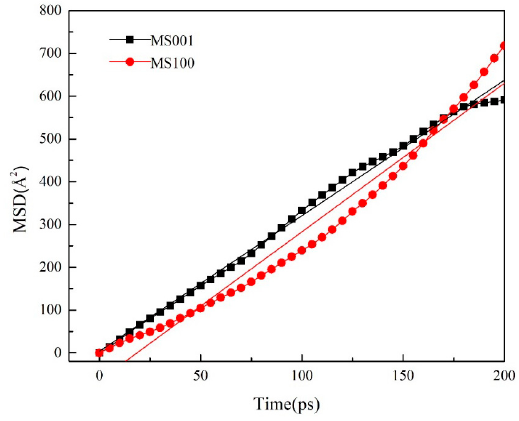
Figure 4. MSD curves of SCA on the MS001/MS100.